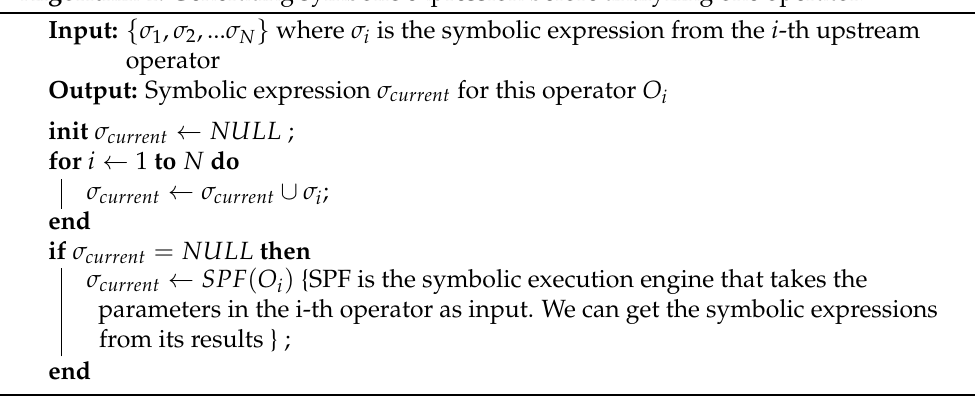
Algorithm 1: Generating symbolic expression before analyzing one